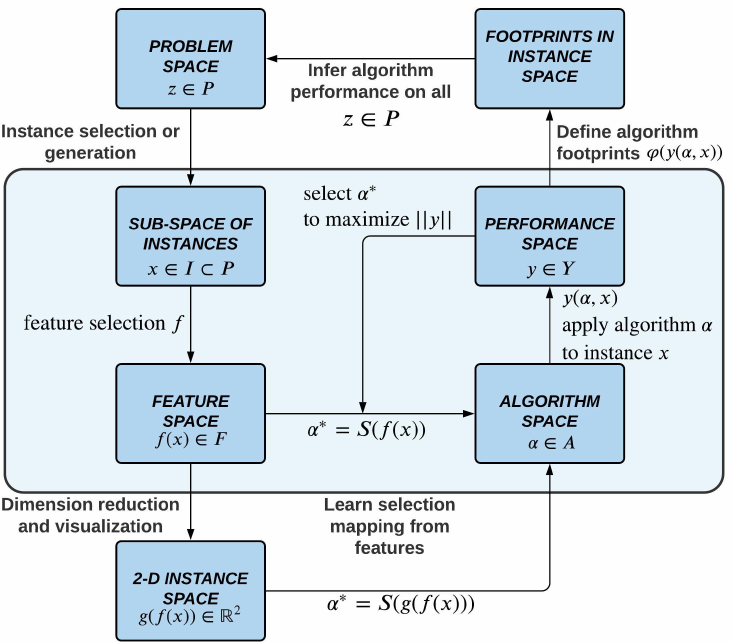
Figure 2. Instance Space Analysis (ISA) framework, building upon Rice’s algorithm selection